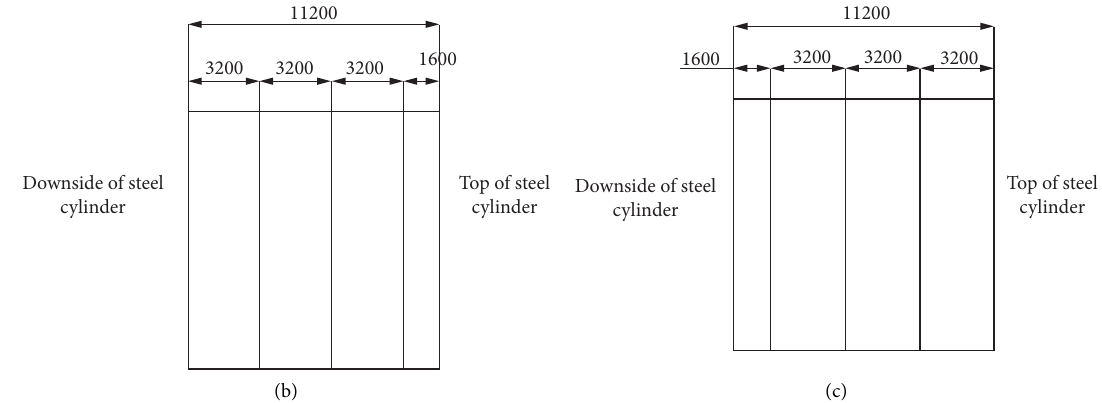
Figure 10: Upper section segments: (a) section segments (top view); (b) type C cylinder design (side view); (c) type D cylinder design (side view).